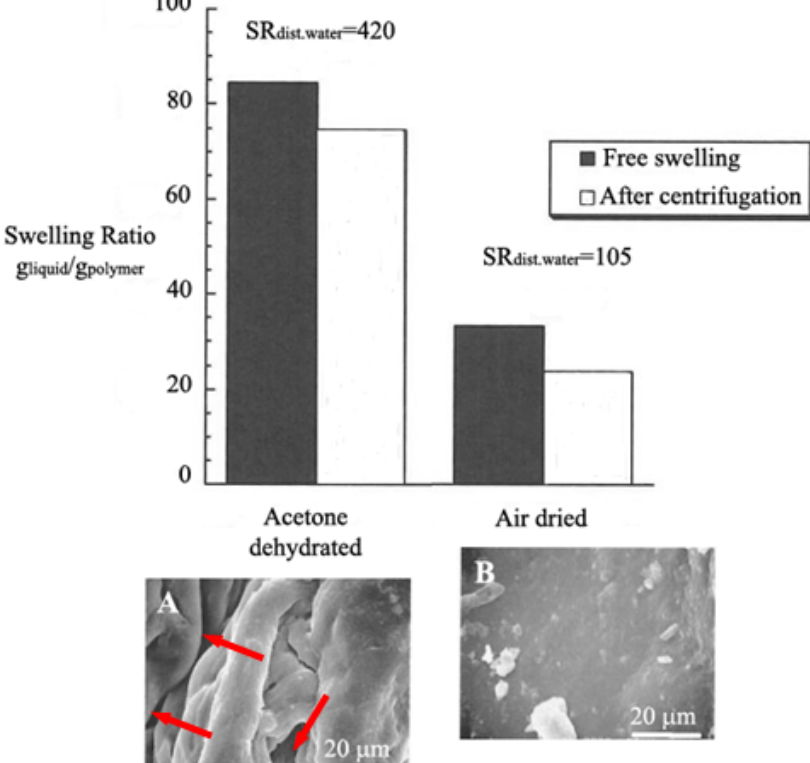
Figure 2. Average uptake of synthetic urine by NaCMC/HEC hydrogels, both in free swelling conditions and after centrifugation [56]. The swelling ratio SR is provided for acetone-dehydrated hydrogels (SEM micrograph A: red arrows indicate the voids or micropores), and air-dried ones (SEM micrograph B: smooth surface with no pores; exogenous white particles are likely due to air drying and manipulation). The values of SR in distilled water are also provided